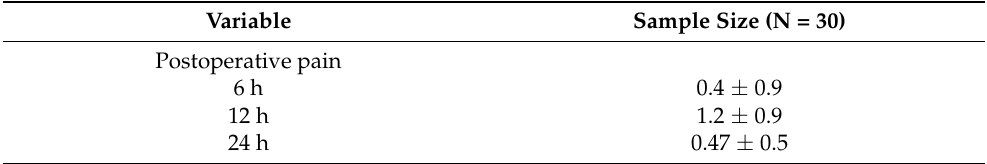
Table 3. Postoperative pain characteristics expressed through the numerical rating scale (NRS), incidence of transient residual nerve block, early and major complications, and length of stay. Data are expressed as percentages and as mean +/ − SD. Length of stay values expressed as median and